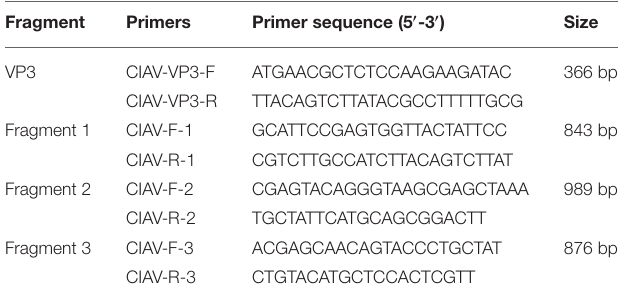
TABLE 1 | Primers for the identification of CIAV.